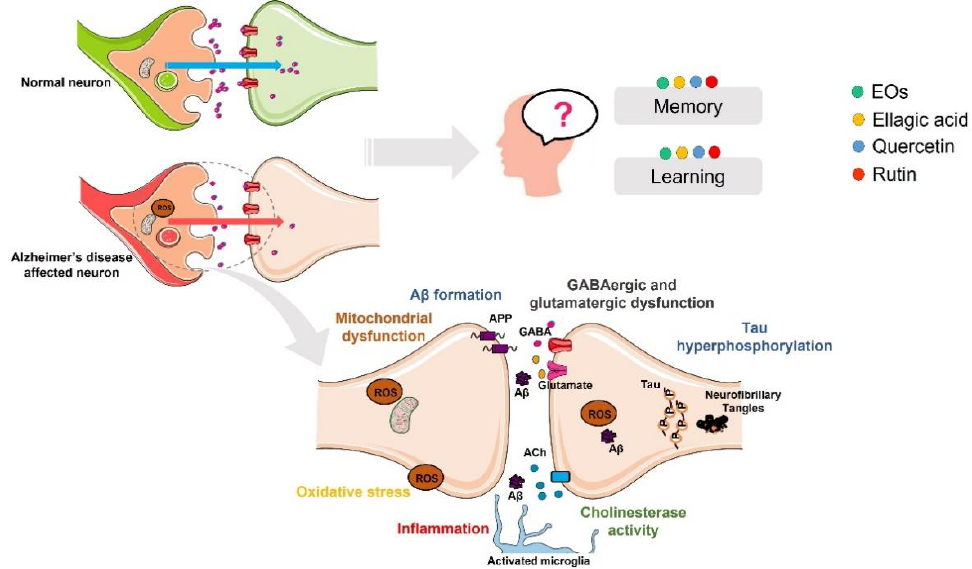
Figure 8. Effect of compounds obtained from E. globulus leaves in the AD-associated memory and learning impairment. learning